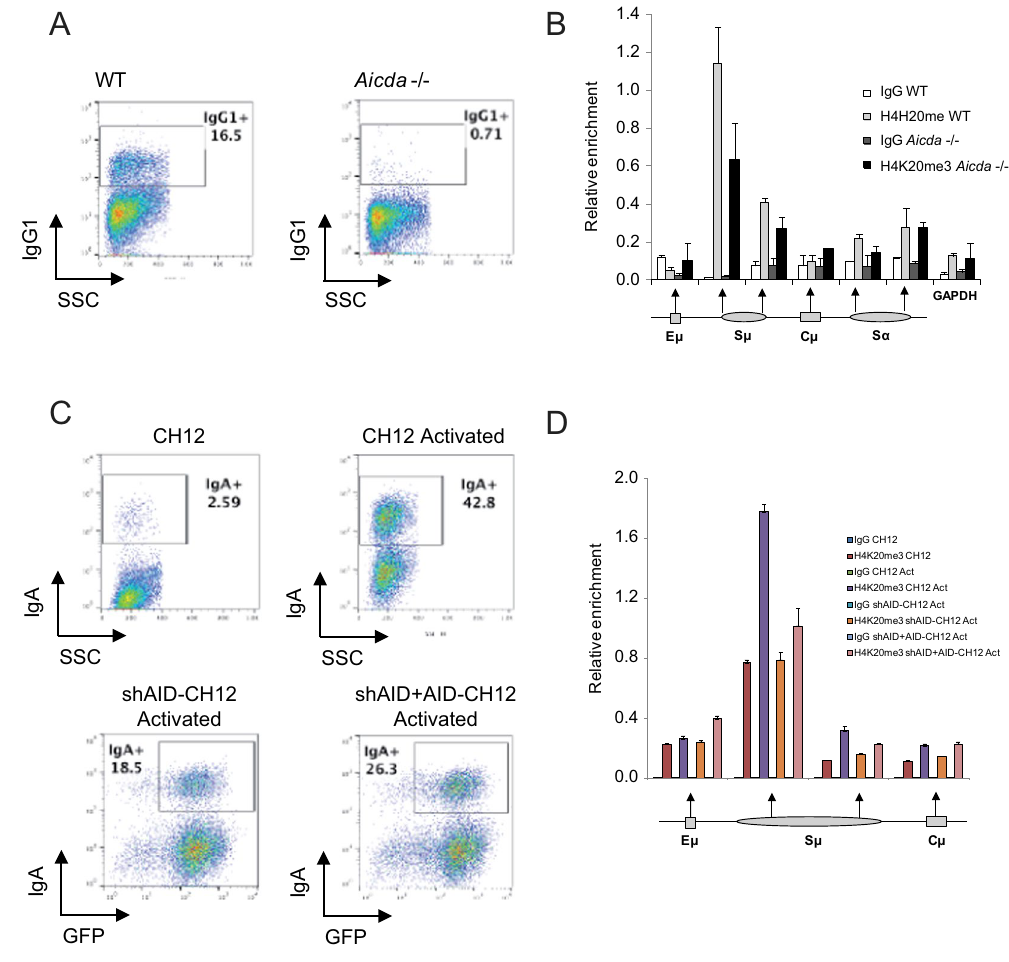
Figure 5. Role of AID in H4K20me3 deposition at IgH locus in switching primary B cells. ( A ) Primary B cells were isolated from wild type (WT) or Aicda − / − mice and then activated with LPS (5 μ g/ml) and IL4 (30 ng/ ml) for 3 days. After that, cells were stained to check class-switch recombination to IgG1. ( B ) Cells were also fixed, lysed and chromatin sonicated to perform ChIP assays with control IgG or anti-H4K20me3 antibodies. H4K20me3 deposition at IgH locus was analyzed using primers for specific regions where AID binding has been previously reported. Y-axis shows the relative enrichment of bound fraction with respect to input fraction. ( C ) Mouse CH12F3-2 cells were activated with 1ng/ml recombinant human TGF- β 1, 10 ng/ml recombinant murine IL-4, and 1 µ g/ml functional grade purified anti–mouse CD40 for switching to IgA. Additionally, CH12F3-2 cells stably expressing shRNA against mouse AID were complemented with human AID by retroviral transduction and then activated in the same conditions. CSR was analyzed 72hrs after activation by flow cytometry, after staining cells with Anti-Mouse IgA-PE and propidium iodide, for excluding dead cells. ( D ) For ChIP, CH12F3-2 cells were also fixed, lysed and chromatin sonicated to perform ChIP assays with control IgG or anti-H4K20me3 antibodies. H4K20me3 enrichment at IgH locus was analyzed using primers for specific regions where AID binding has been previously reported. Y-axis shows the relative enrichment of bound fraction with respect to input